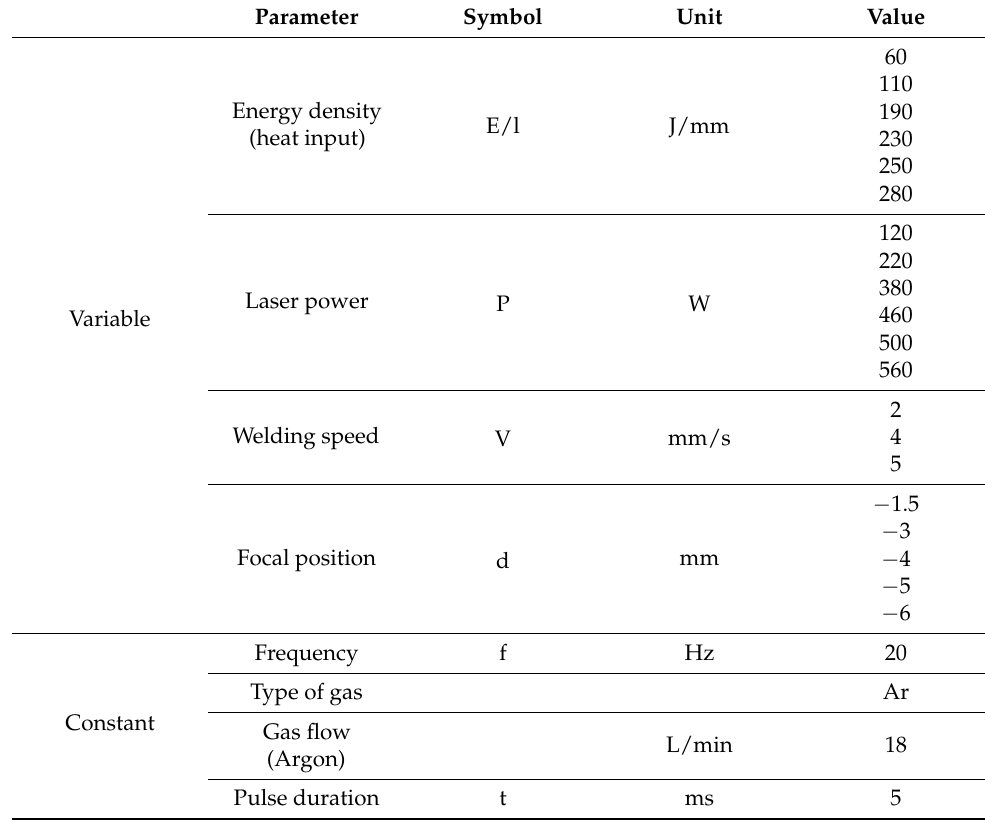
Table 2. Experimental parameters for the serum and air